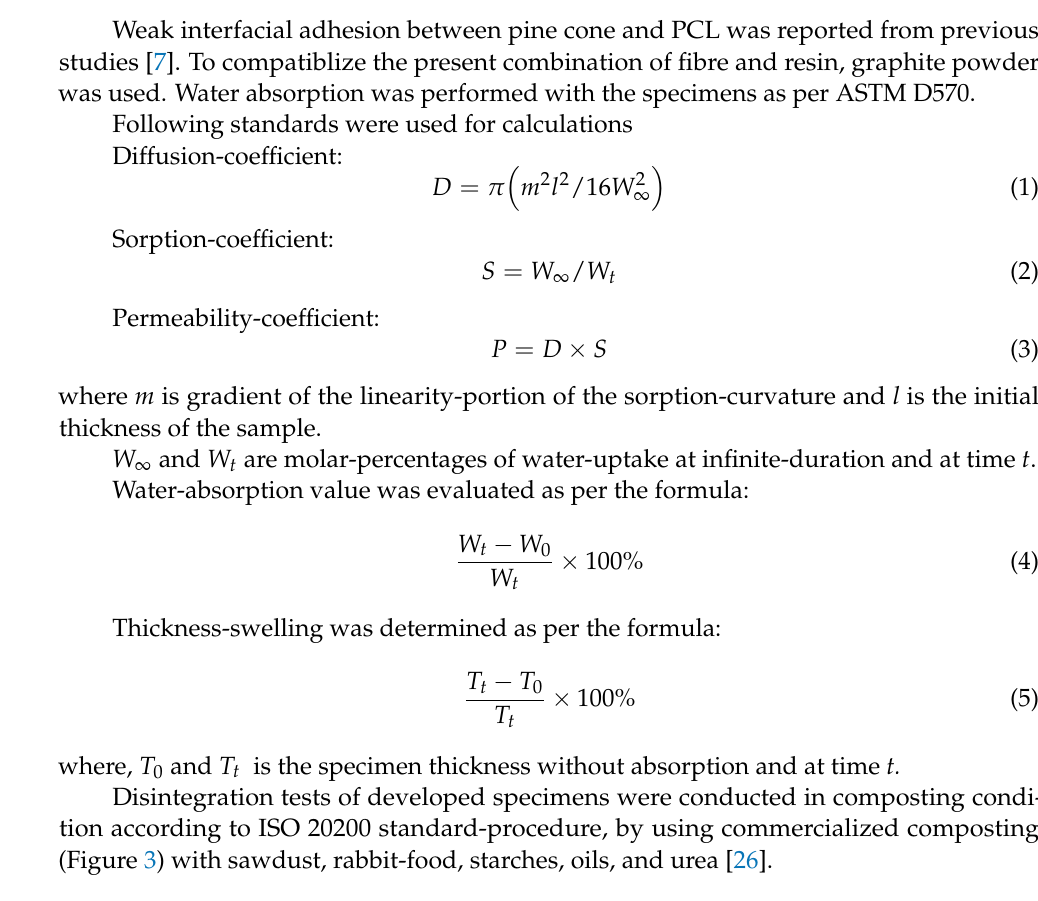
Figure 2. Schematic representation of alkali treatment of secondary wall of